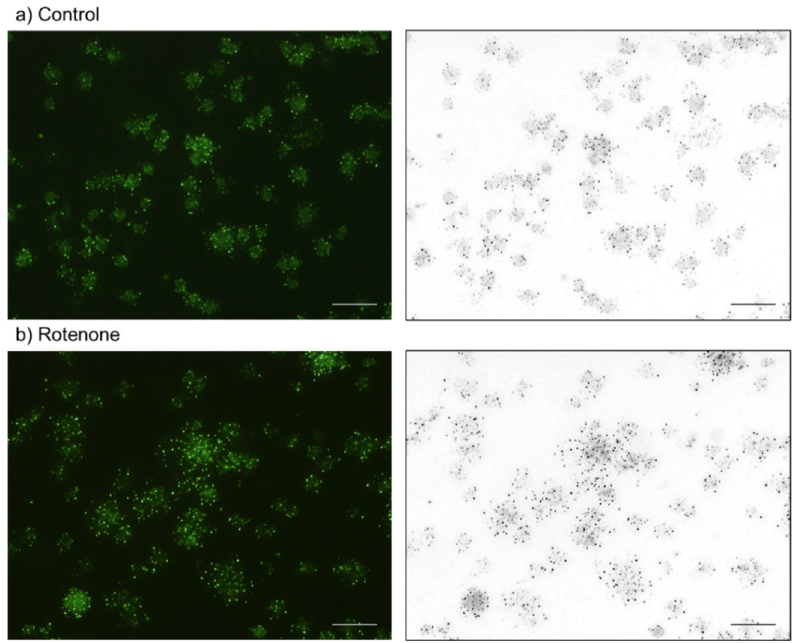
Figure 10. The effects of rotenone on platelet polyP (green and black microparticles in left and right columns, respectively). Platelets were treated with 20 μ M rotenone ( b ) for 20 h. The control con- tained only the solvent (DMSO) ( a ). Bar = 10 μ m. Similar results were observed in four other inde-